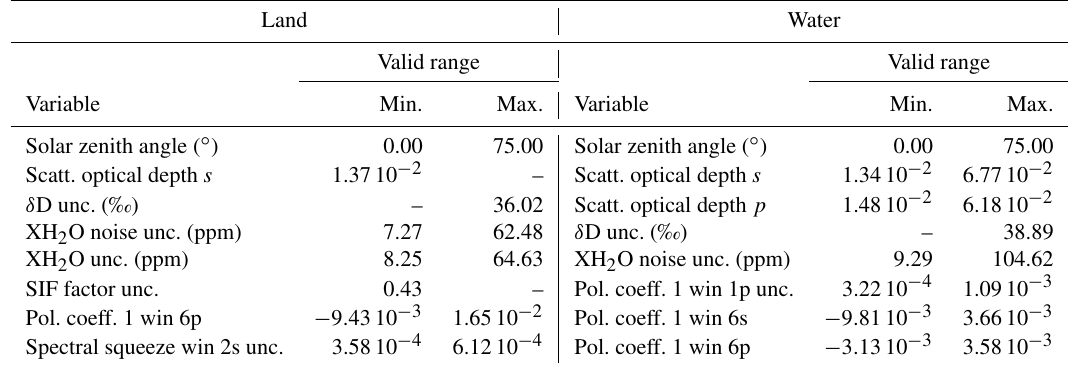
Table A5. δ D filter variables and limits for GOSAT. “–” means that no limit is applied. Except for the solar zenith angle limits, the variables are ordered by their relevance, i.e. by the number of data filtered